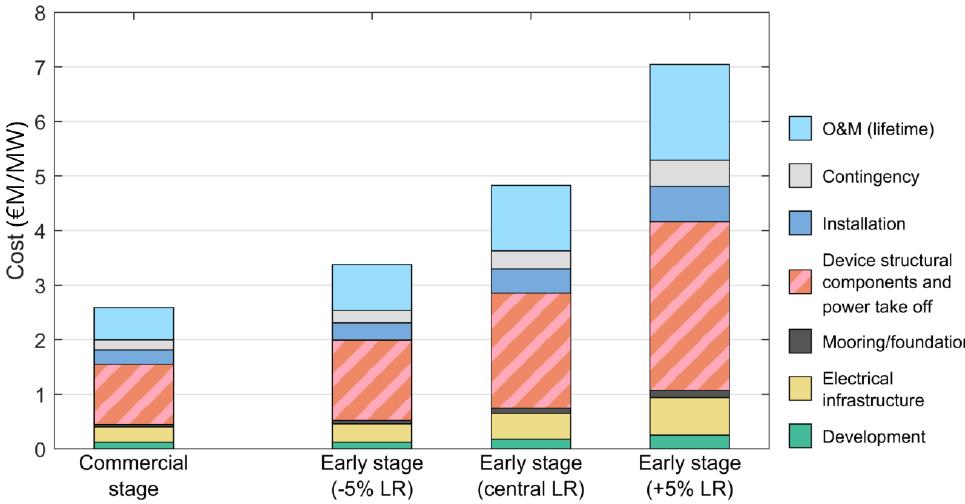
Figure 5. Results per cost centre for floating offshore wind commercial-stage and early-stage CAPEX. Note that some subsystems are combined, shown by hatched bars.